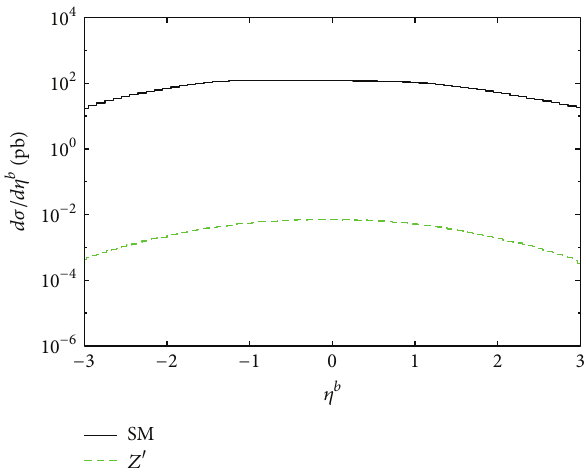
Figure 13: The pseudorapidity distribution of the bottom quarks ( 𝑏 and 𝑏 ) for the signal ( 𝑍 󸀠 ) and background processes (SM) 𝑝𝑝 → (𝑊 + 𝑏𝑡+𝑊 − 𝑏𝑡)+𝑋 at the LHC with √𝑠 = 13 TeV for the parameters explained in the text. The results are obtained for the 𝑍 󸀠 𝜂 model.